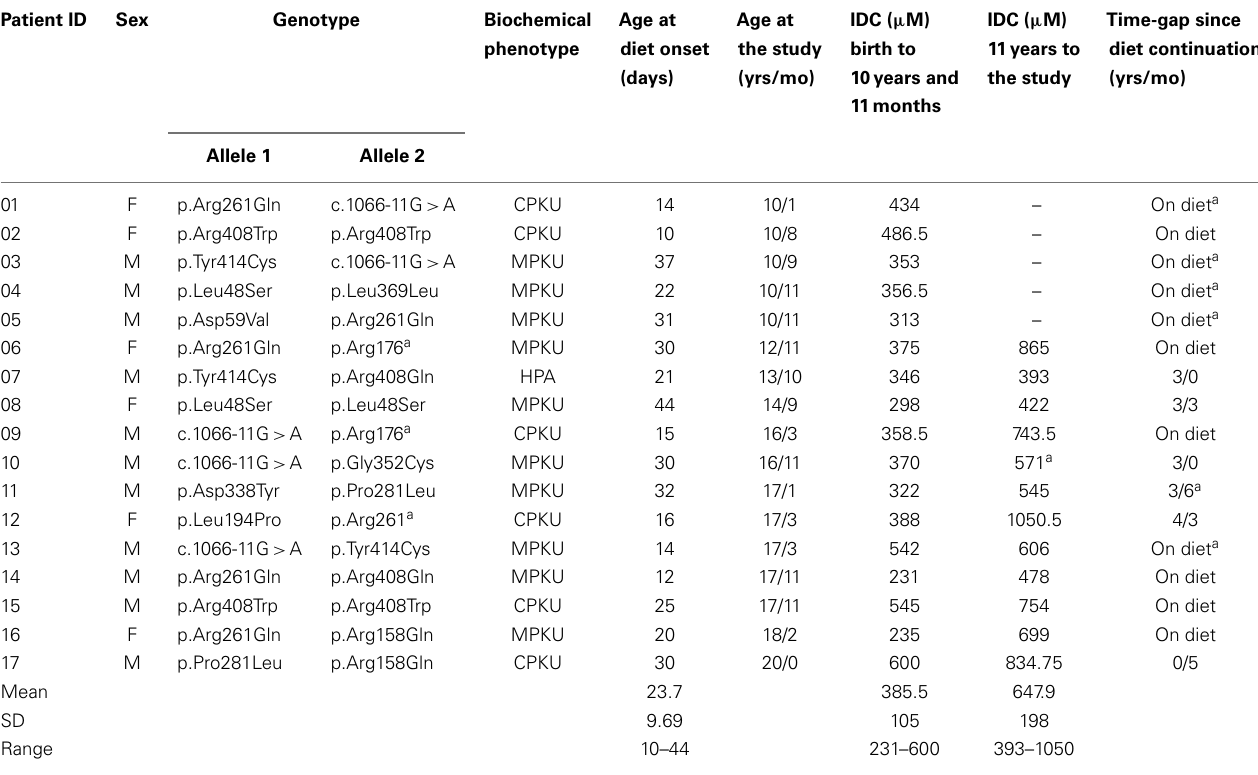
Table 1 | Demographic and clinical characteristics of the PKU sample